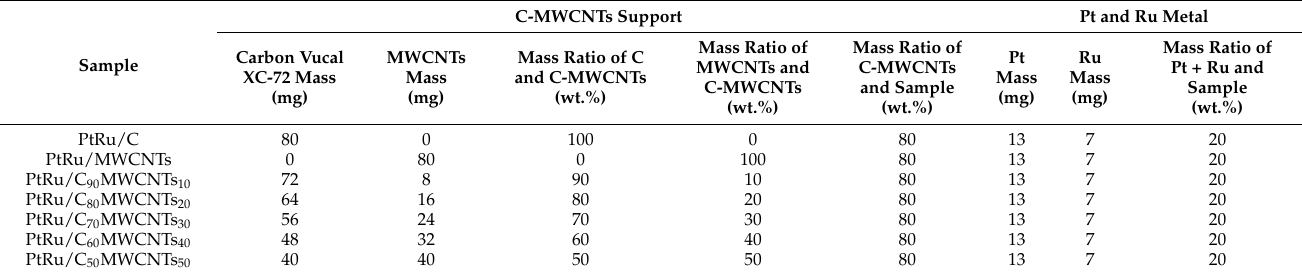
Table 1. Detailed preparation conditions of the catalytic samples